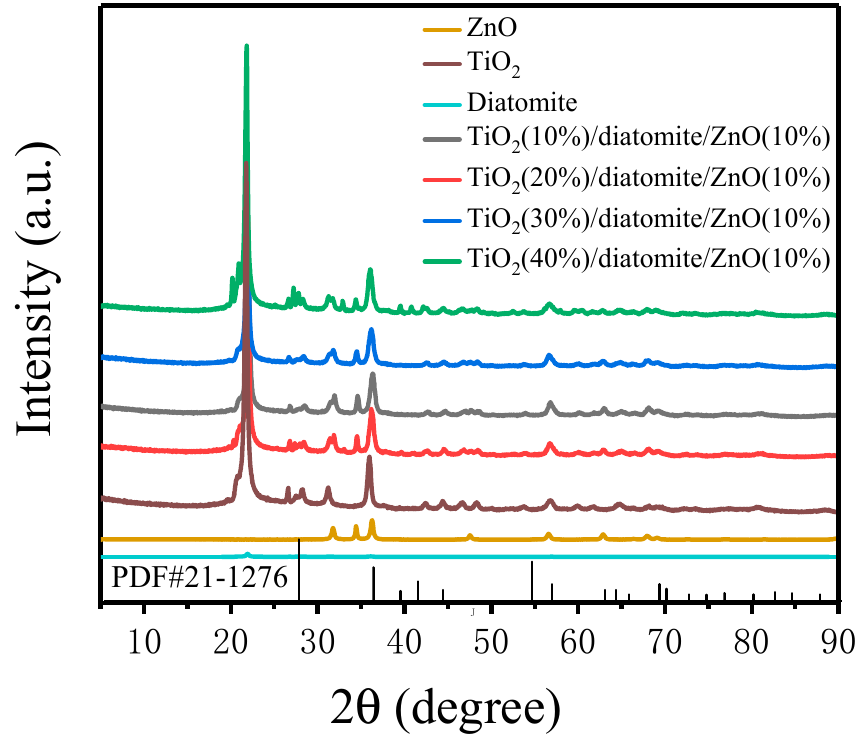
Figure 1. XRD figures of pure diatomite, pure ZnO, pure TiO 2 , and TiO 2 (X%)/ZnO(10%)/diatomite.